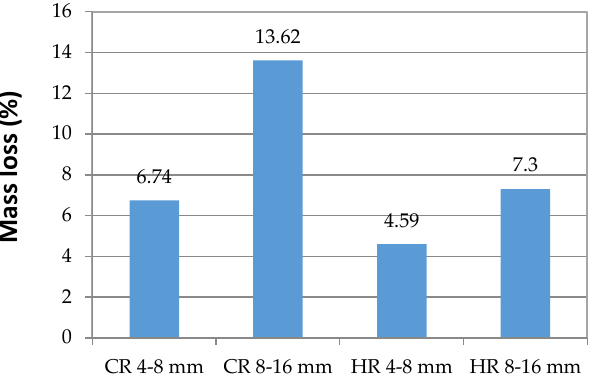
Figure 9. Resistance to freezing and thawing expressed by mass loss.